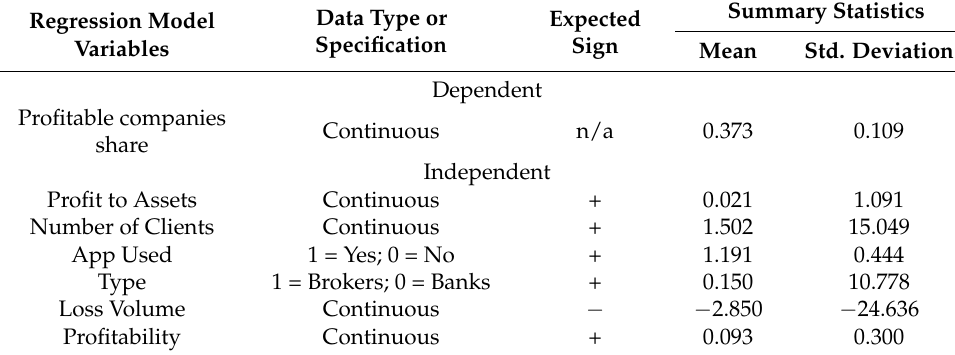
Table 5. Summary statistics from the regression model.